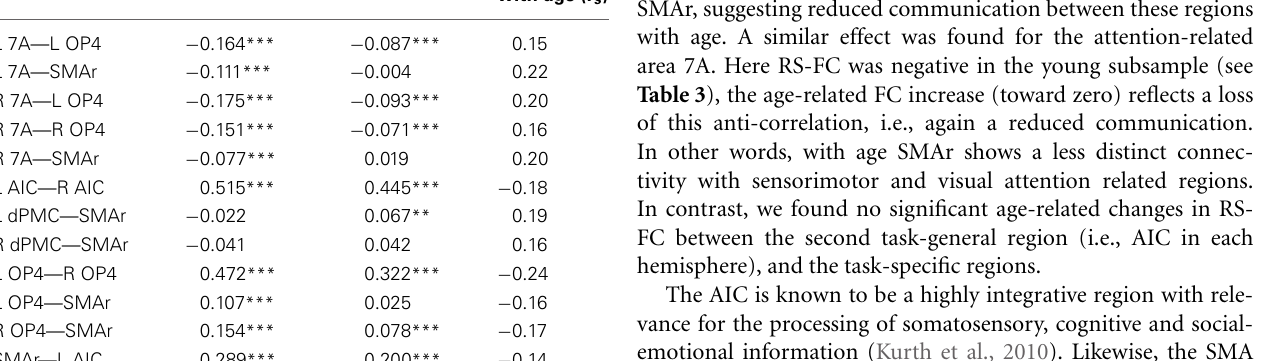
Table 3 | Age differences in intrinsic functional connectivity.